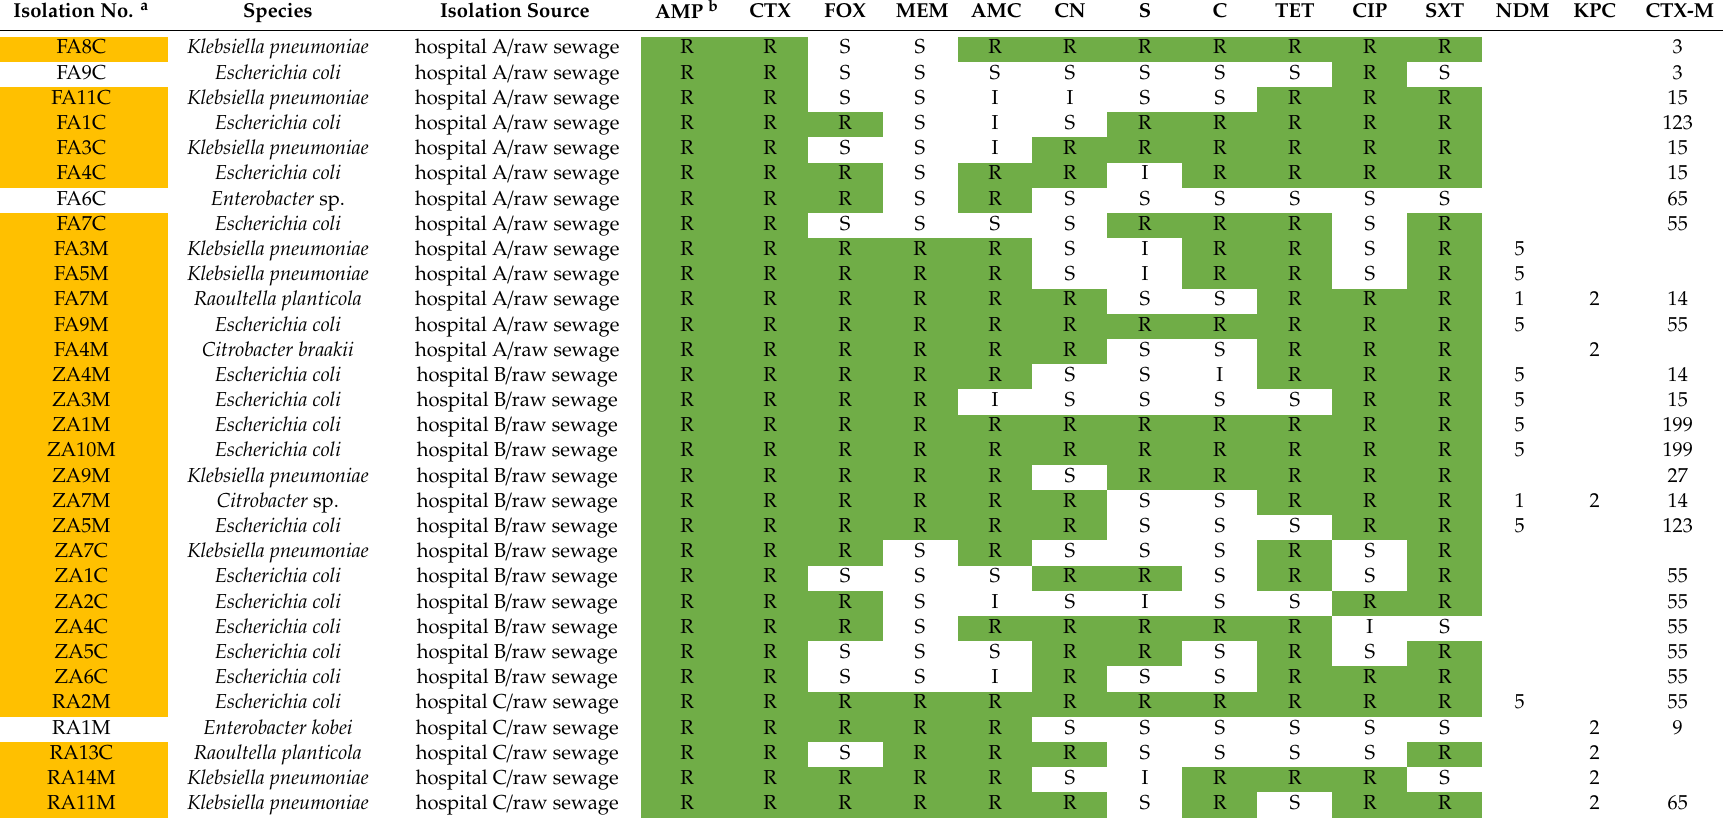
Table 1. Enterobacteriaceae isolated from aquatic